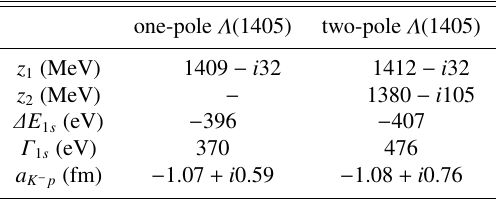
Table 1. Physical characteristics of the obtained one-pole and two-pole potentials: pole positions z 1 and z 2 , level shift ∆ E 1 s and width Γ 1 s of kaonic hydrogen, and corresponding exact strong scattering length a K − p . Threshold branching ratios (10) and (13) are reproduced